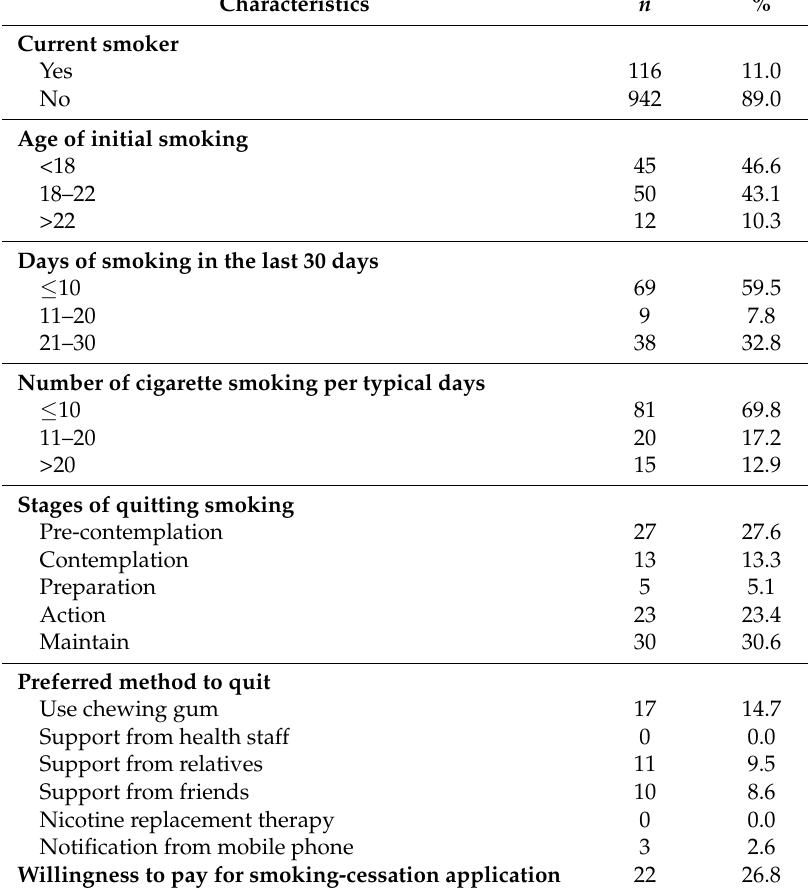
Table 3. Smoking and quitting behaviors among smoking respondents ( n =